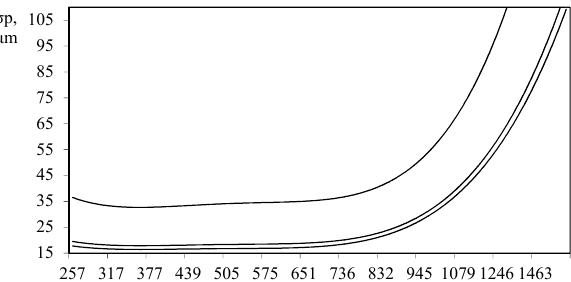
Fig. 2. The graph of the dependence of the energy of the mutual spatial spectrum of the images on the value of the stereo shooting basis